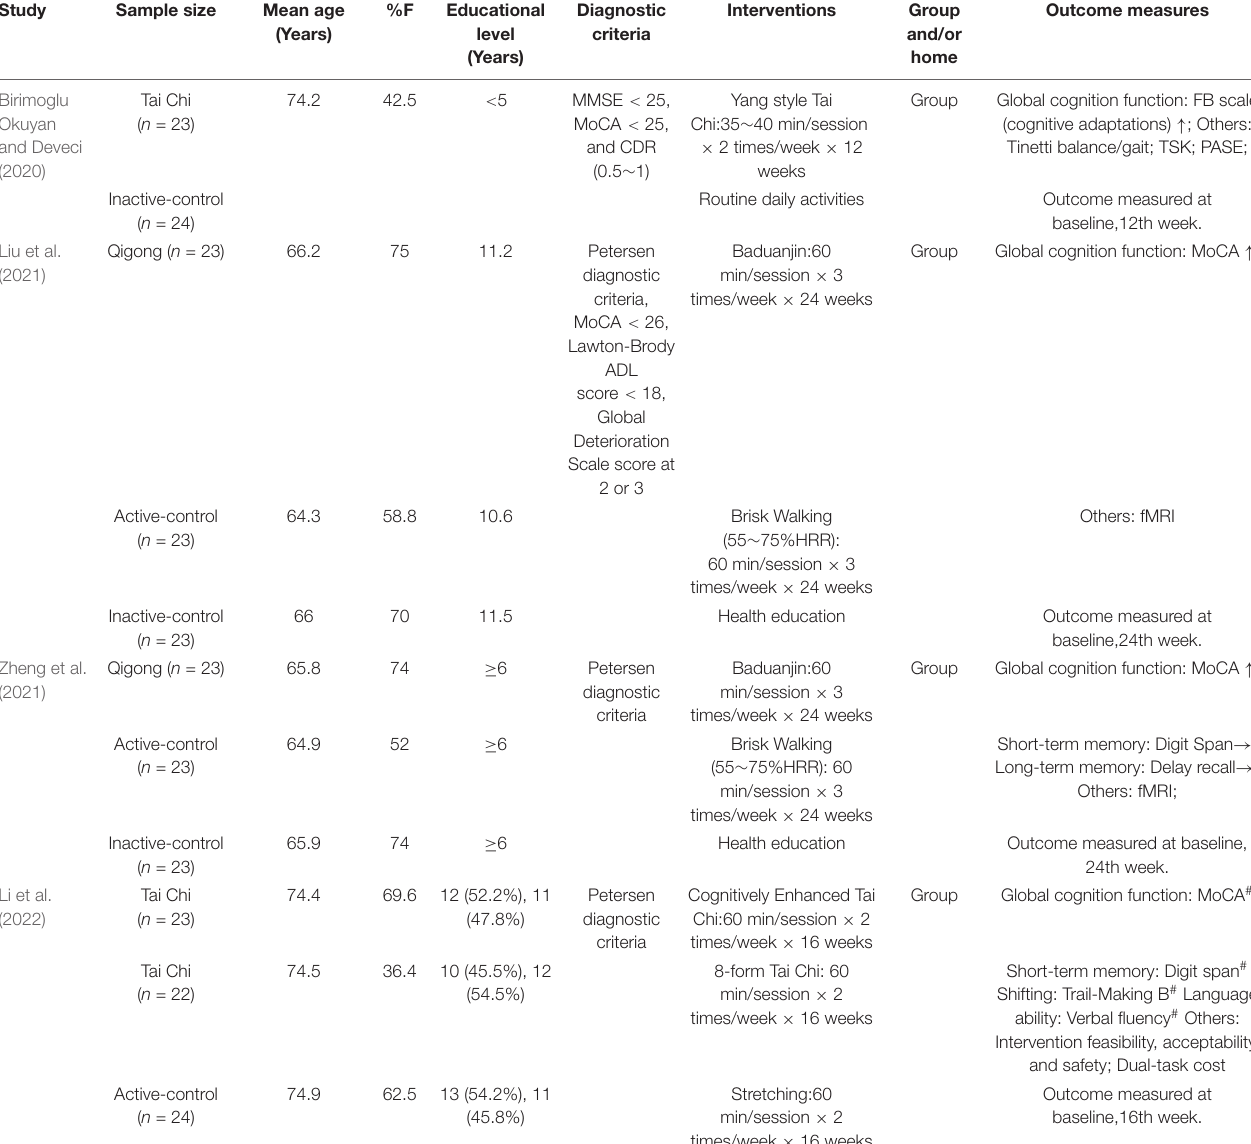
and Yang style Tai Chi ( n = 1). The sub-types of Qigong included the studies used active control. Specifically, two compared the effects between 24-form style Tai Chi and stretching exercises (Lam et al., 2011, 2012); one compared the effect between 8-form Tai Chi and stretching (Li et al., 2022); and another one compared